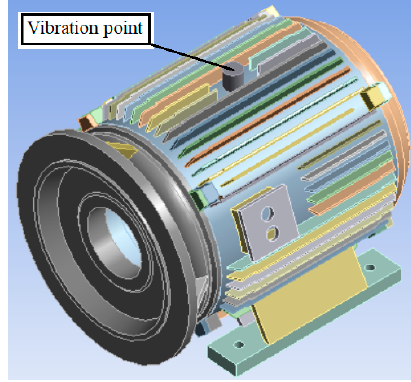
Figure 15. 3D structure model of a motor.